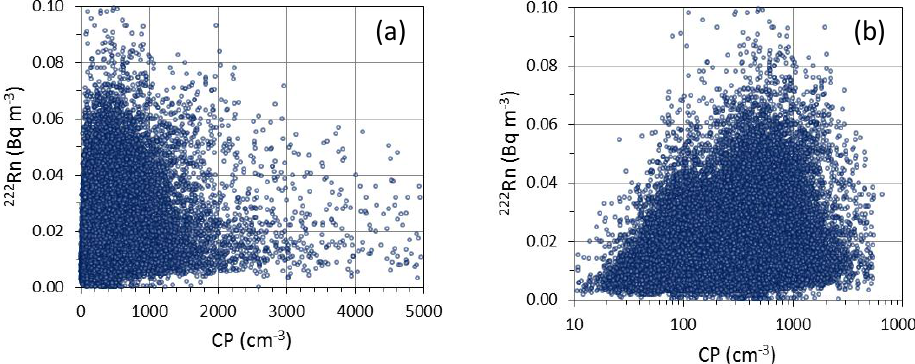
Fig. 9. Relation between CP concentrations presented on (a) linear as well as (b) on logarithmic scale and 222 Rn activity concentrations. Data points correspond to 3h means, i.e. the highest available temporal resolution of the measured 222 Rn activity concentrations. The calculated Pearson correlation coefficient is r = 0 . 213 ( r 2 = 0 . 045; N =